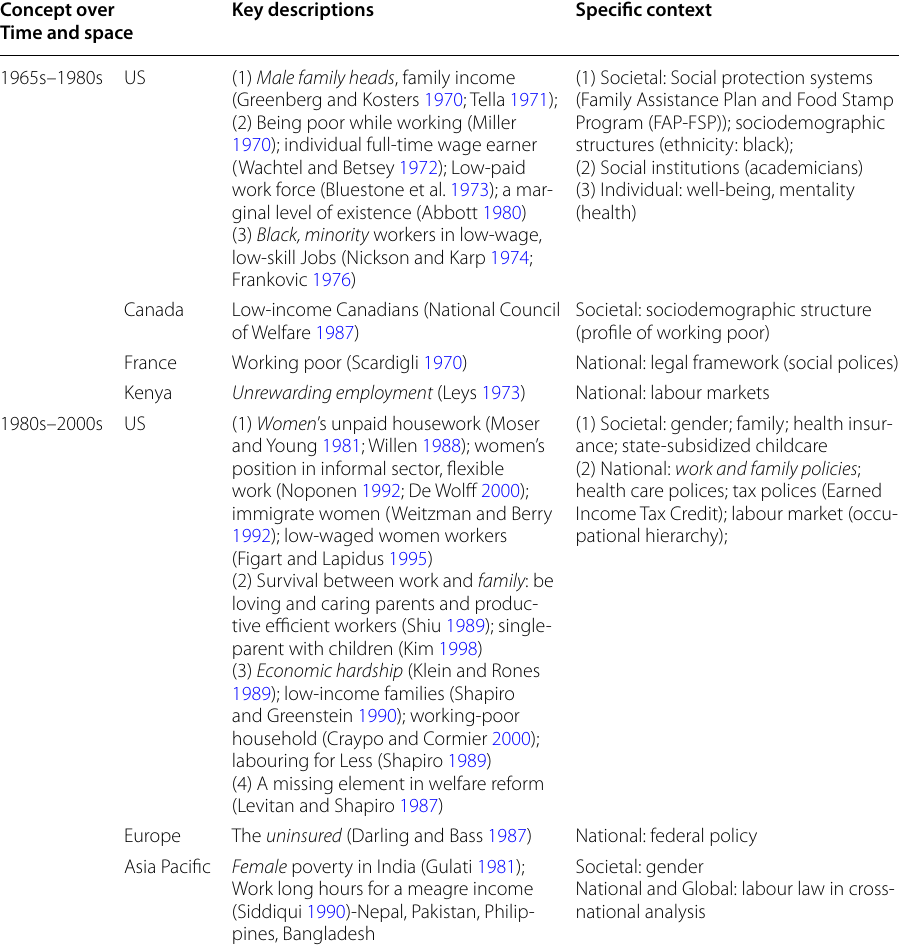
Table 2 Key definitions or conceptions in in-work poverty research (1965s-2000s) Concept over Time and